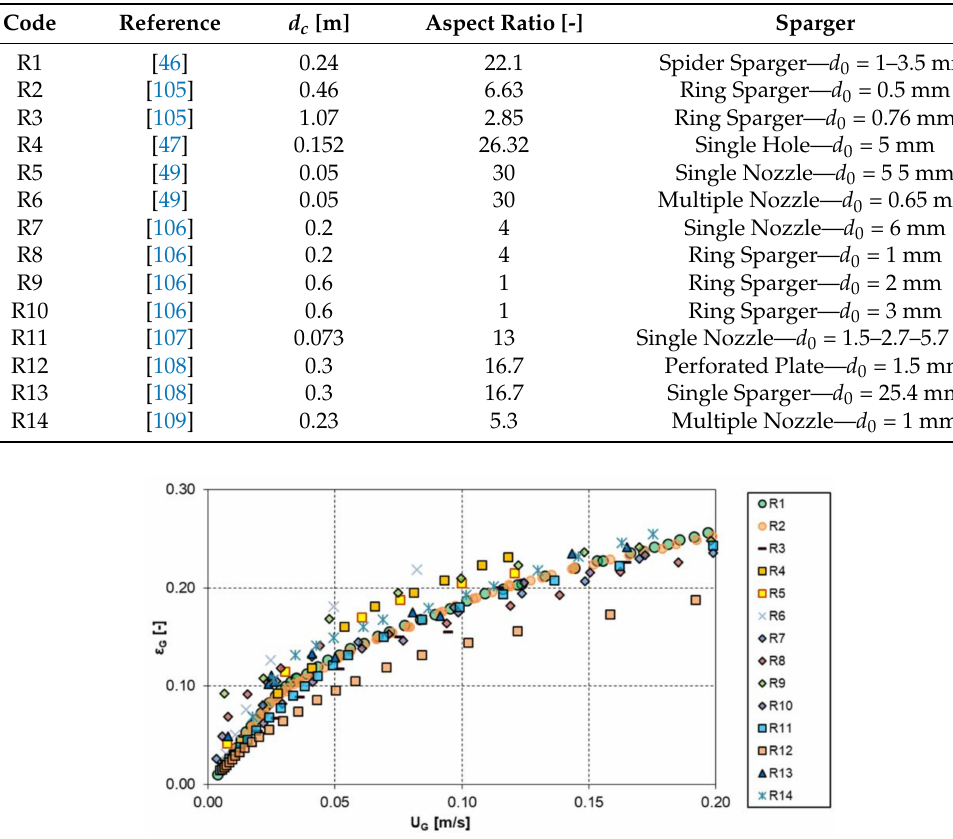
Table 1. Literature studies (reference codes for Figure 14).